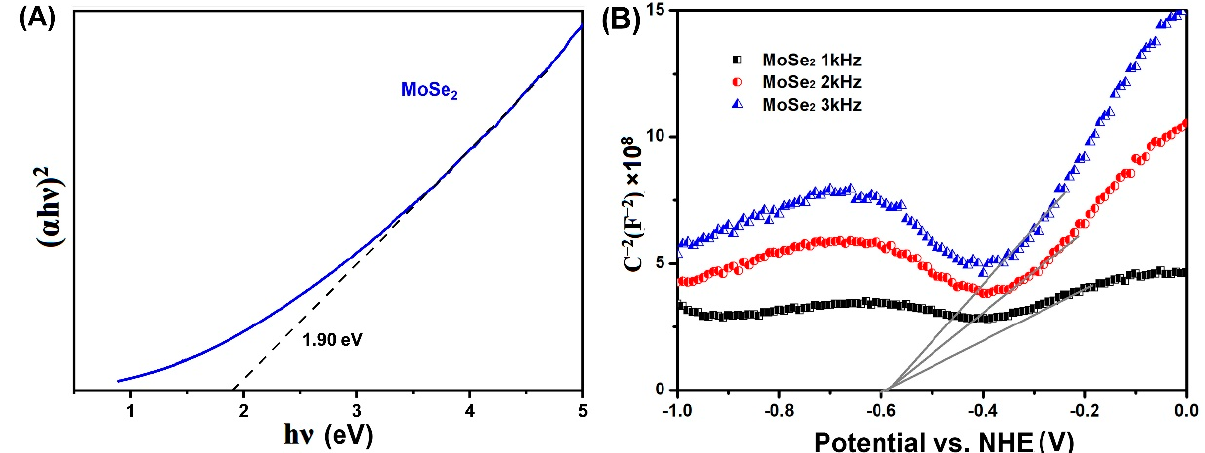
Figure 6. ( A ) Plots of ( α h ν )1/2 (MoSe2) versus photon energy (h ν ); ( B ) Mott–Schottky plots of MoSe 2 .